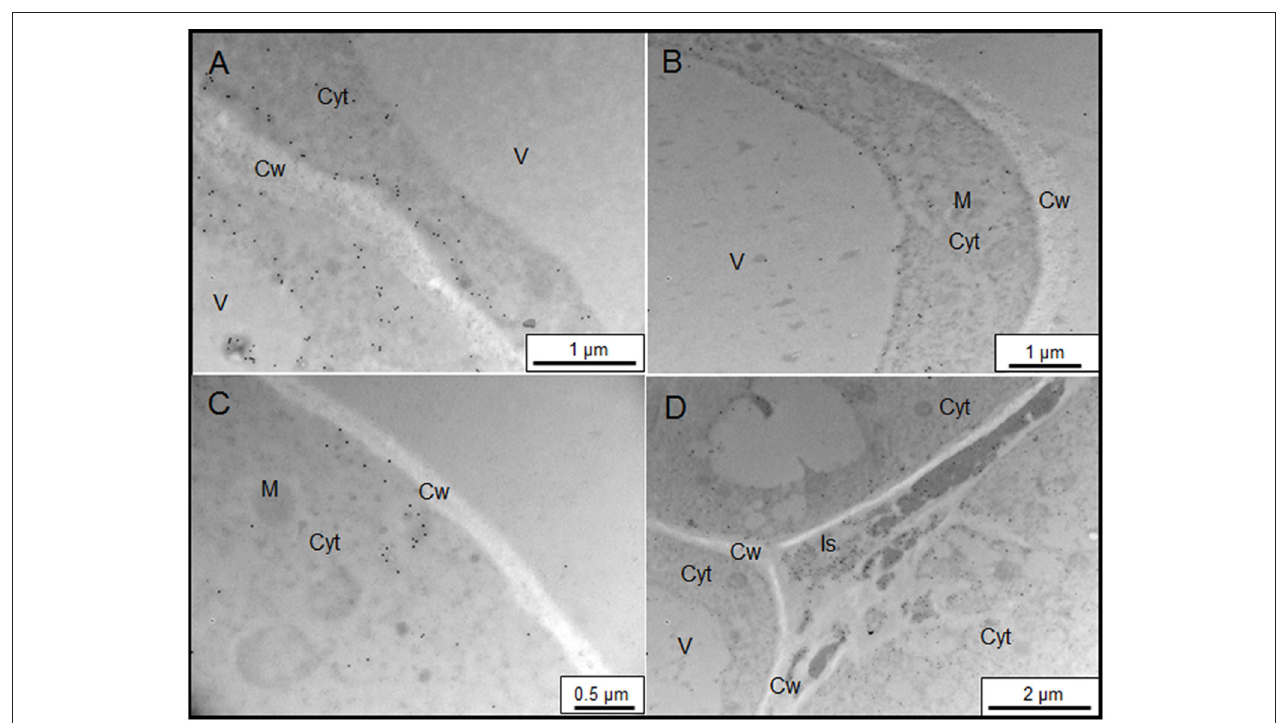
FIGURE 3 | Immunogold labeling of JIM15 AGP epitope on samples of control (A,B) and salt-adapted (C,D) tobacco BY-2 cells. (A) Detail of cell wall showing a high labeling at the plasma membrane. (B) General view of control cells showing abundant labeling in the cytoplasm. (C) Details of plasma membrane with low labeling but showing abundant vesicles with high labeling. (D) JIM15 epitope secreted to the apoplast in three-way cell-cell junction. Cyt, Cytoplasm; Cw, Cell Wall; Is, Intercellular space; M, Mitochondria; V, Vacuole.